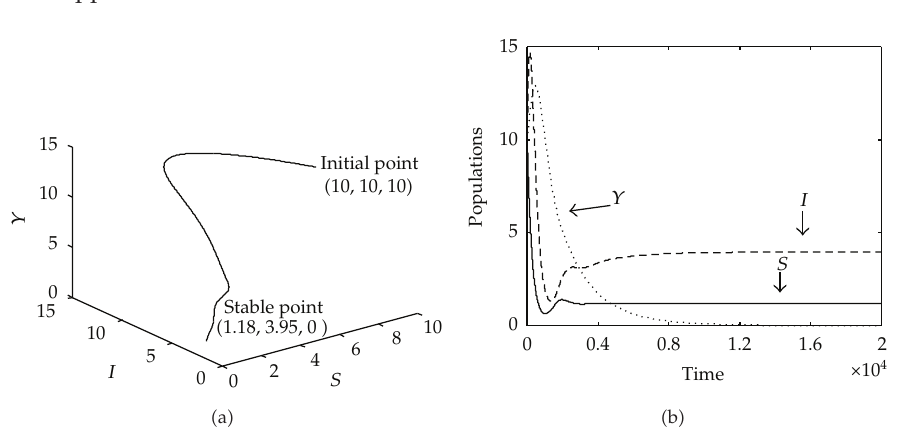
Figure 5: (cid:5) a (cid:6) System (cid:5) 2.1 (cid:6) approaches stable point in Int. R 2 (cid:7) of the SI -plane for λ (cid:8) 1 . 25 with the rest of parameters are given by (cid:5) 6.1 (cid:6) . (cid:5) b (cid:6) Time series of the trajectory in (cid:5) a (cid:6) .